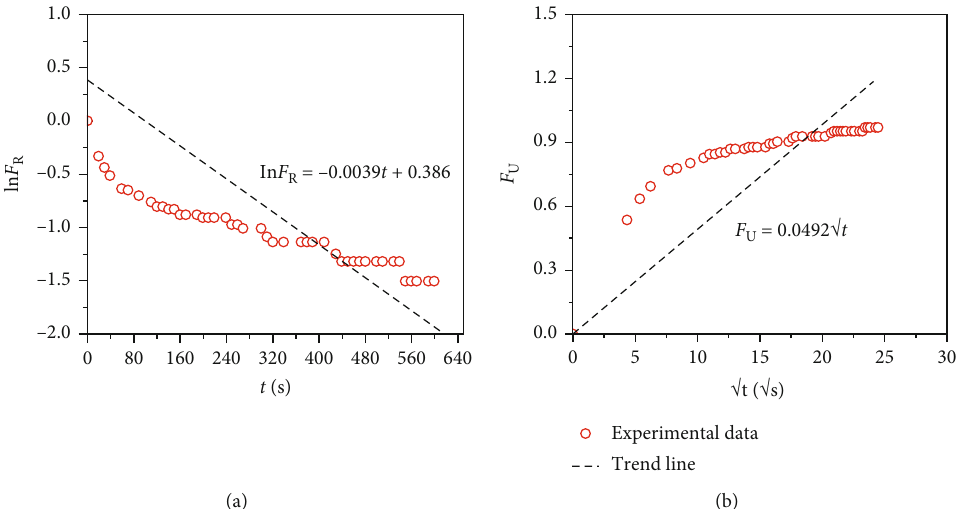
is the mass fraction out of the R